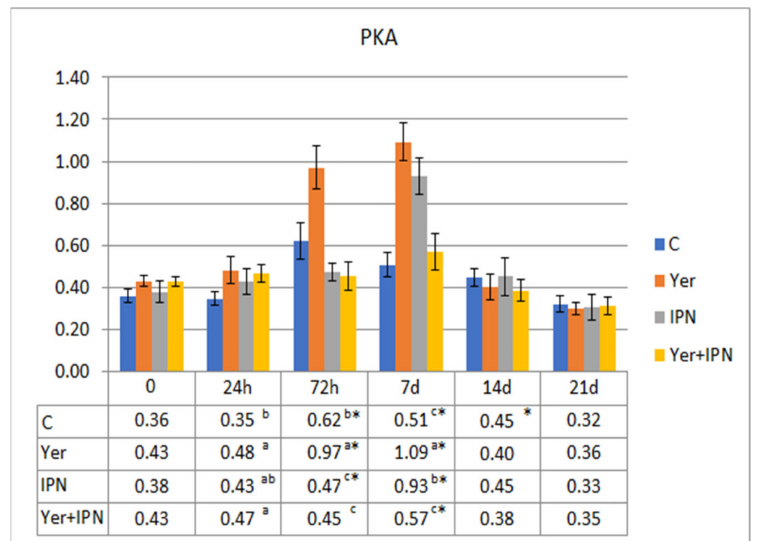
Figure 10. Mean values and standard deviation of potential killing activity of phagocytes over the course of the first experimental infection. *—statistically significant differences compared to the day 0 values within a given group ( p ≤ 0.05); a, b, c —statistically significant differences between the groups on a given sampling day ( p ≤